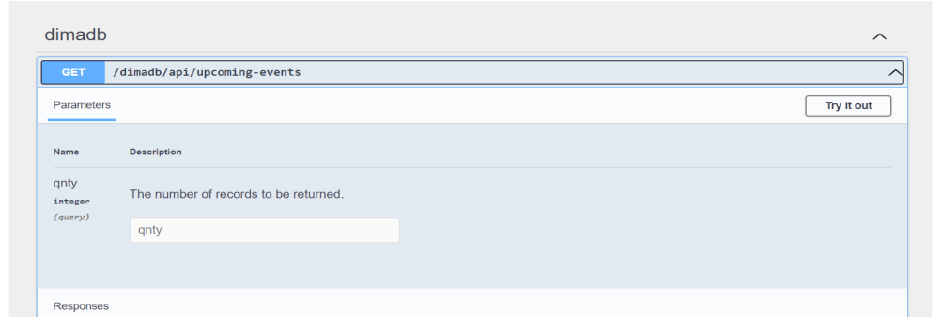
Fig. 7. Upcoming events recommender